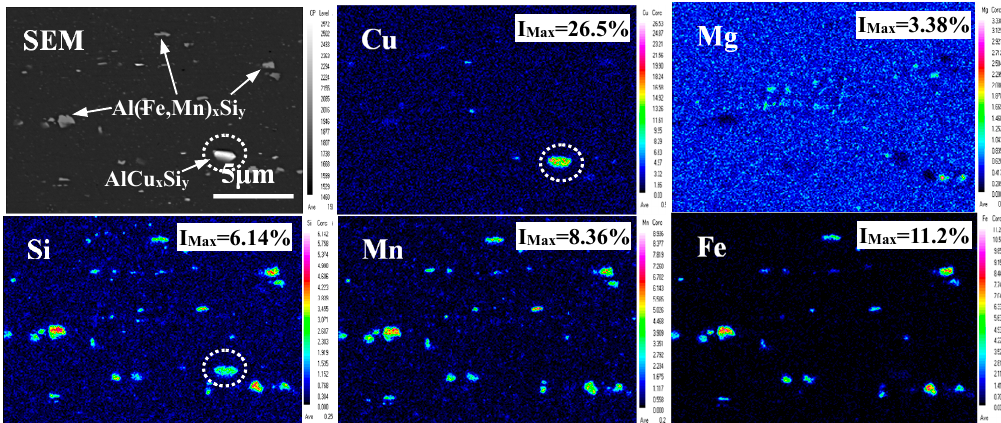
Figure 5. Elemental mapping of the as-extruded Alloy 1 examined by EPMA.